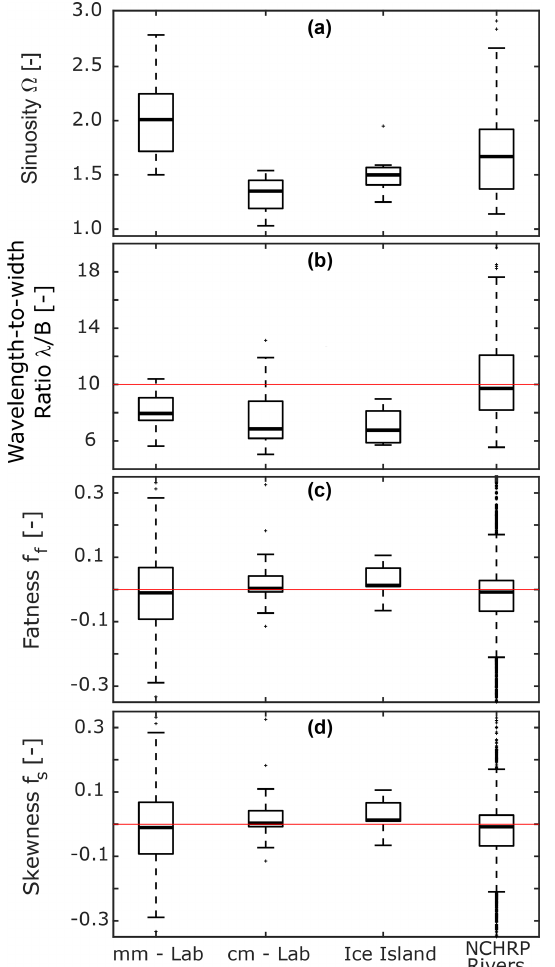
Figure 10. (a) Sinuosity, (b) wavelength-to-width ratio, (c) fatness, and (d) skewness of meltwater meandering channels and the rivers in the NCHRP (see text) database.